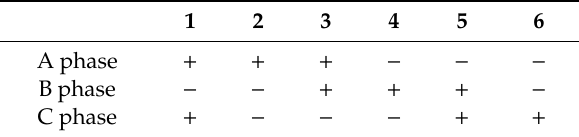
Table 2. Three-phase winding current flow table at different points.